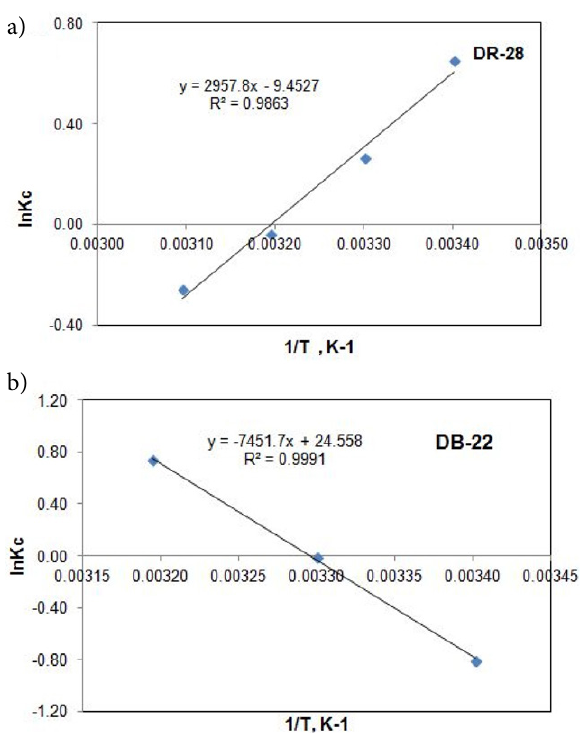
Fig. 12. The thermodynamics of the adsorption of (a) DR-28 and (b) DB-22 on the adsorbent KZF (pH: original, initial concentra- tion: 30 mg/L, contact time: 60 min, KZF amount: 1 g/mL)